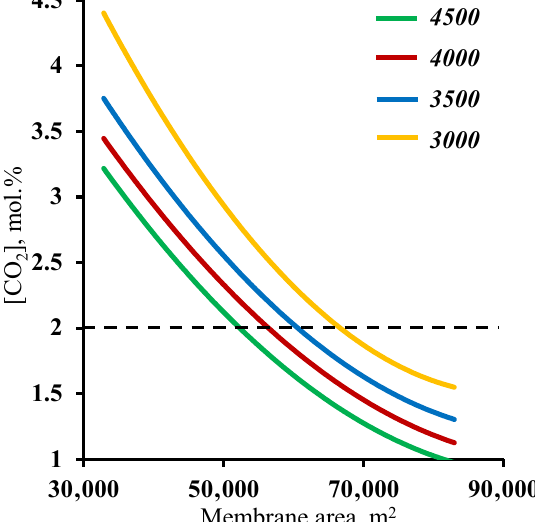
Figure 6. Dependence of carbon dioxide recovery rate on the membrane area in the enrichment section (M2 and M3) for eight different fixed membrane area values in the stripping section (M1).